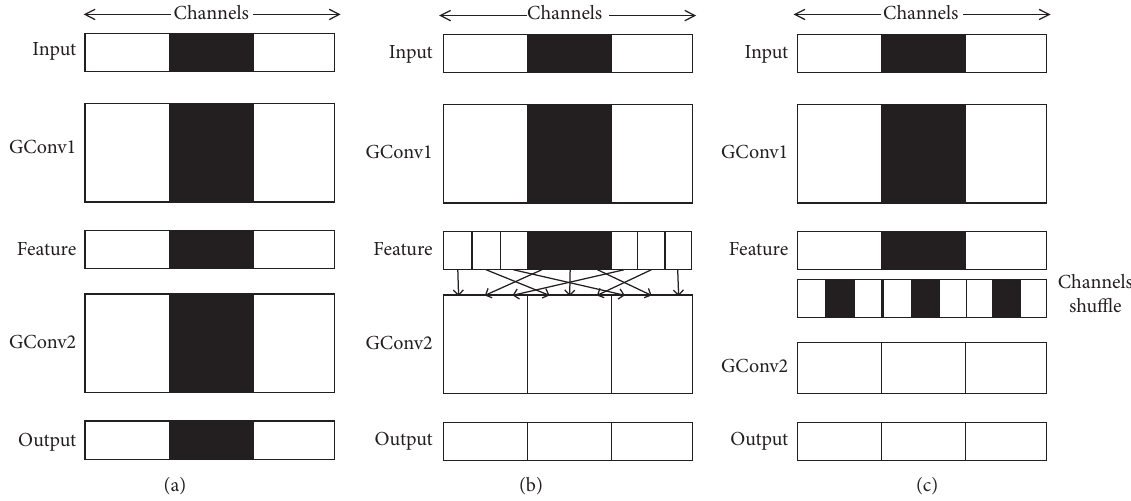
Figure 5: Schematic diagram of channel shuffle. (a) Grouped convolution. (b) Apply shuffle. (c) shuffle effect.